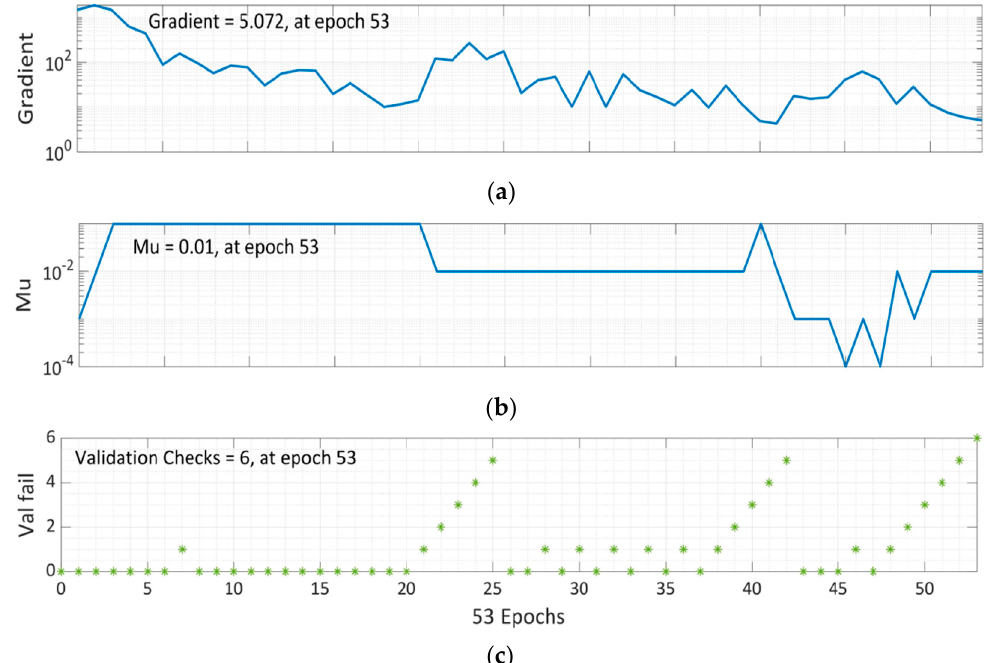
Figure 9. Training State of LM Algorithm: ( a ) Gradient graph at epoch 53; ( b ) Mu graph at epoch 53; ( c ) Validation checks graph at epoch 53.